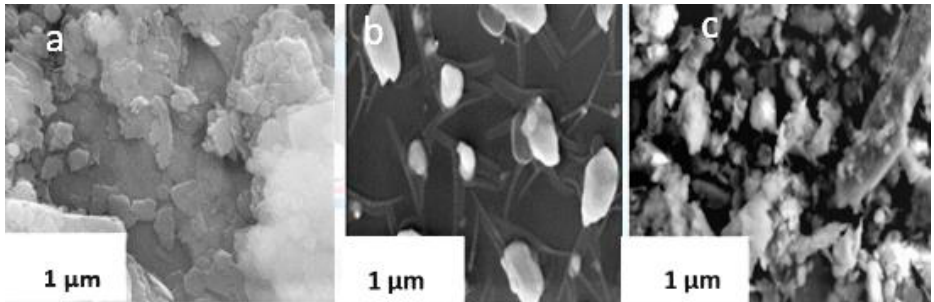
Figure 5. Scanning micrograph of the bioflocculant ( a ), kaolin particles ( b ), and flocculated kaolin particles ( c ).